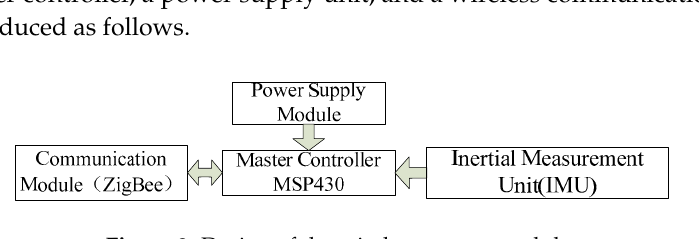
Figure 4. Elliptical trajectory of monitoring nodes.